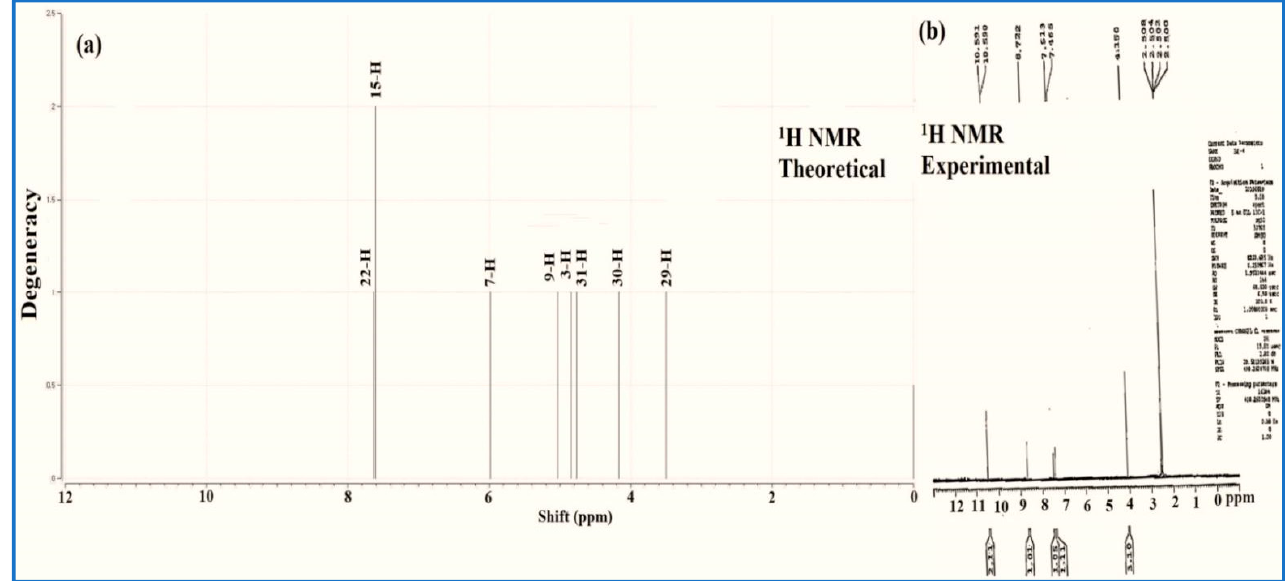
Figure 11. Calculated ( a ) and experimental ( b ) 1 H-NMR spectra of the isolated compound 2 .